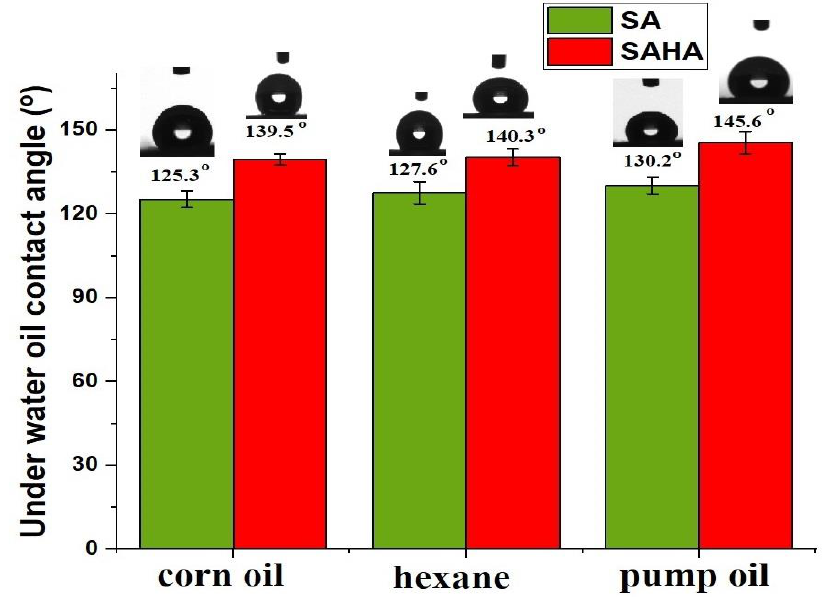
Figure 9. Underwater contact angles of various solvents for SA and SAHA aerogels. Biomolecules 2020 , 10 , x